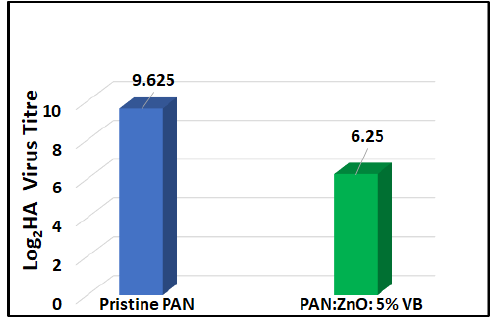
Figure 7. Antiviral activity of pristine PAN and 5% VB-loaded PAN/ZnO electrospun nanofibers.